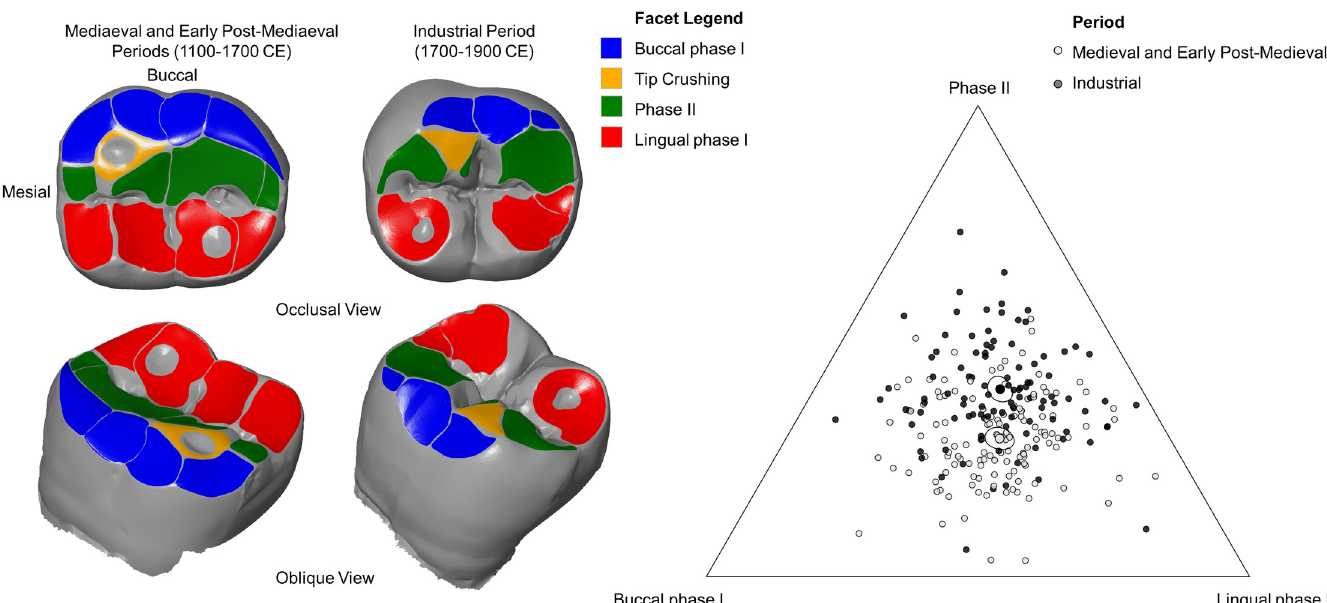
Fig 4. Comparison of dental wear facet patterns between the pre-industrial and industrial groups. Above: Comparison of lower second molar dental wear facet patterns between the medieval and early post-medieval Periods and the industrial Period. Wear facets are marked as follows: buccal phase I facets are blue, lingual phase I facets are red, phase II facets are green and tip crushing areas are orange. Note large phase II wear facets in the industrial period relative to buccal phase I wear. In the earlier periods, lingual phase I wear facets and buccal phase I facets occupy a larger proportion of the overall wear facet area. Below: Ternary plot showing the relationship between period and relative wear facet area of the lower second molar (composed of buccal phase I (BPI), lingual phase I (LPI) and phase II (PII) facet areas). The industrial group is displayed as dark grey circles and the medieval and early post-medieval group as light grey circles. The centre value for each period is represented as a larger filled shape surrounded by 95% confidence regions. The industrial group is represented by a large black circle and the medieval group a white circle.